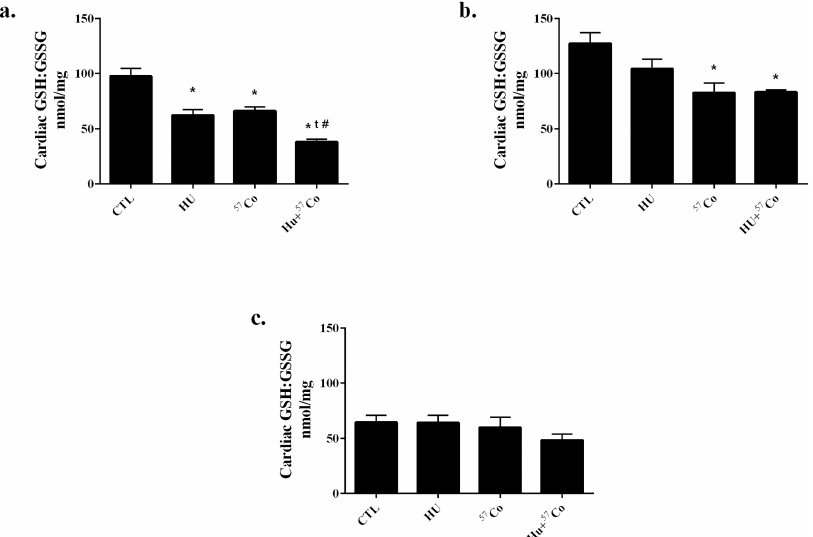
Fig 1. GSH:GSSG ratios in mouse heart following HU, γ irradiation or combined HU + γ irradiation. HPLC was utilizedto determineGSH:GSSG ratios a.) 7 days, b.) 1 month, or c.) 9 months after a 21 day exposureto HU, γ irradiation( 57 Co: 0.01 cGy/h; 0.04 Gy total), or combinedHU + γ irradiation. Samplesizes: CTL for all time points, n = 6; HU for 7 day time-point, n = 4; HU for 1 month time-point, n = 5; HU for 9 month time-point, n = 6; 57 Co for 7 day and 9 month time-points, n = 5; 57 Co for 1 month time-point, n = 6; HU+ 57 Co for 7 day time-point, n = 6; HU+ 57 Co for 1 and 9 month time-points, n = 5. Values are means ± SEM. * Significantly different than CTL, p < 0.05; t Significantlydifferent than HU, p < 0.05; # Significantly different than 57 Co, p < 0.05.